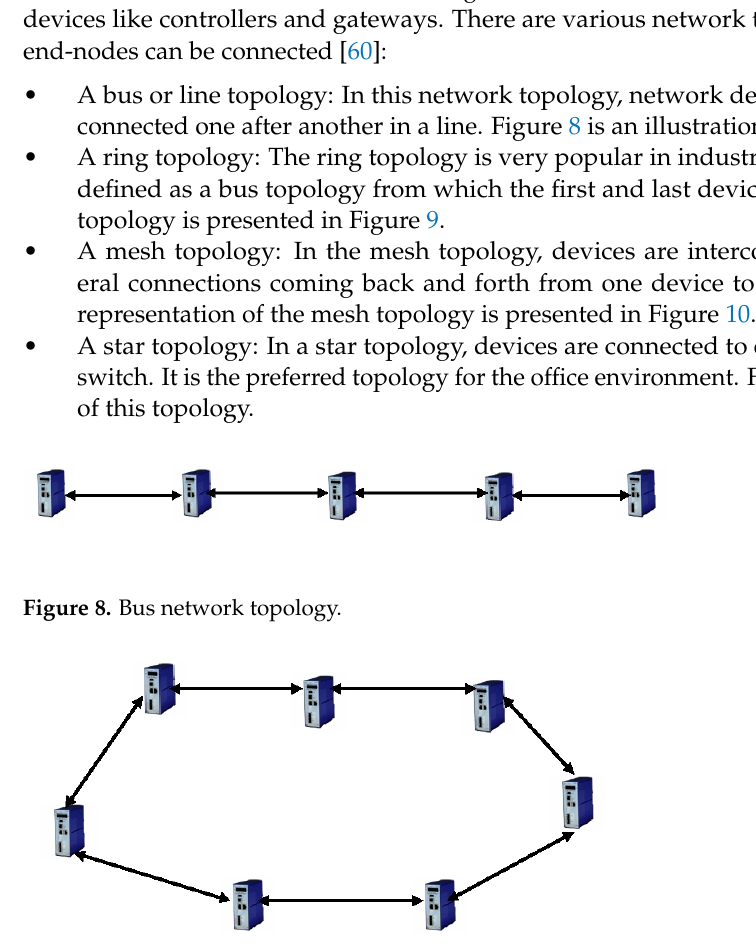
Figure 9. Ring network